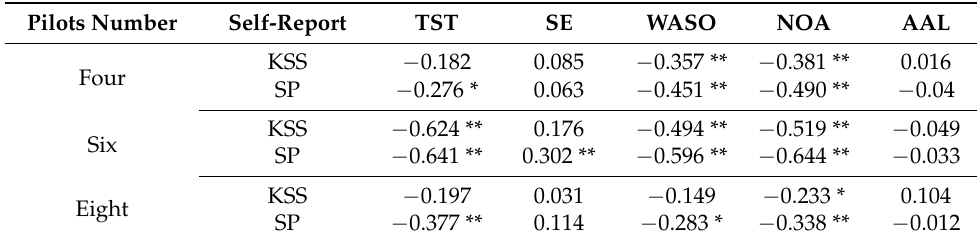
Table 5. Correlation between self-assessment and